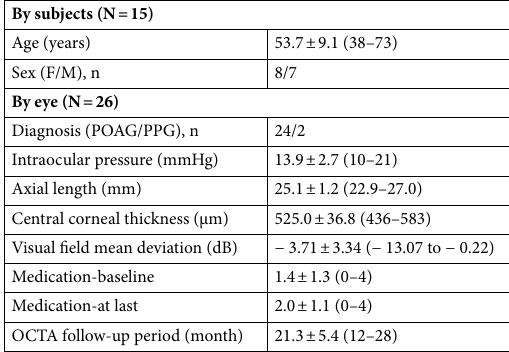
Table 1. Demographic and clinical characteristics of included subjects (N = 26 eyes of 15 subjects). Data (except sex and diagnosis) are presented as mean ± standard deviation with the minimum and maximum values in parentheses. POAG primary open angle glaucoma, PPG preperimetric glaucoma, OCTA optical coherence tomography angiography.